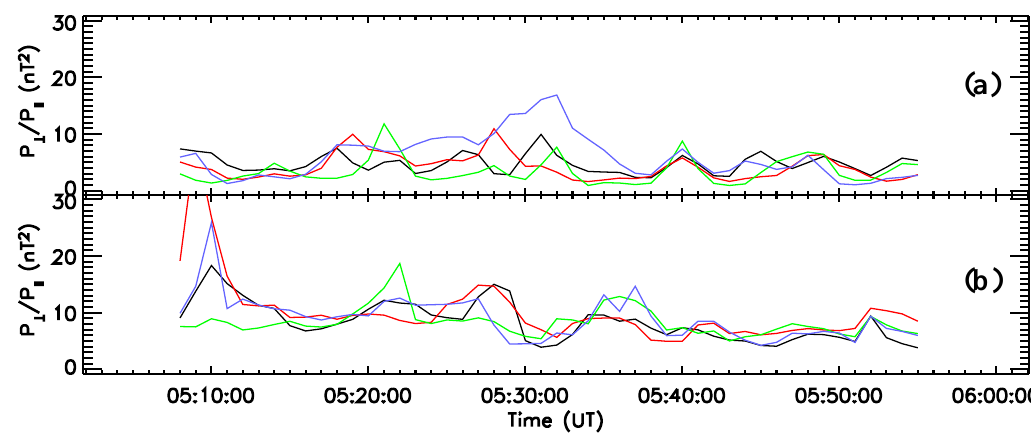
Fig. 6. The ratio of the integrated perpendicular and parallel (with respect to the magnetic field) power, P ⊥ /P || , at the inertial range (a) between 0.015Hz– f bf and at the range between f bf –3.0Hz (b) . Calculations use 8192 point window shifted by 1-min increments over FGM